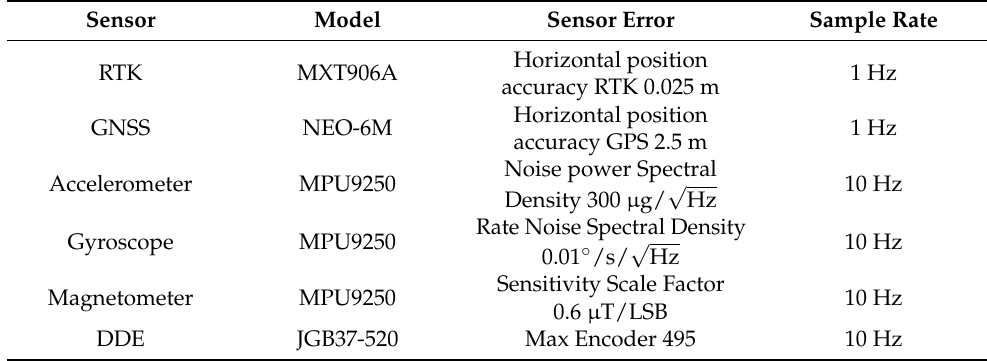
Figure 6. The mechanical structure and sensors of the QJ-Racecar.